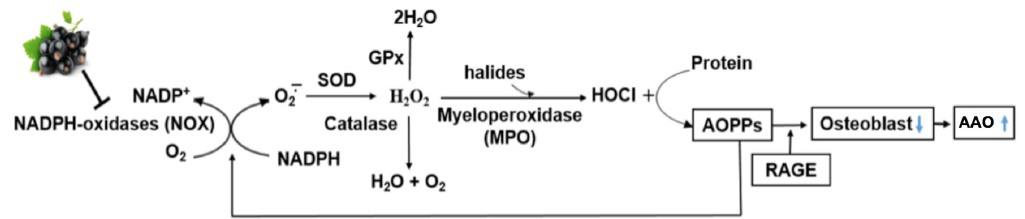
Figure 1. Potential mechanism of anthocyanins in lowering aging-associated osteoporosis (AAO) risk through inhibiting nicotinamide adenine dinucleotide phosphate (NADPH) oxidase (NOX)-mediated advanced oxidation protein products (AOPP) formation. GPx: glutathione peroxidase; RAGE: receptor for advanced glycation end products; SOD: superoxide dismutase.